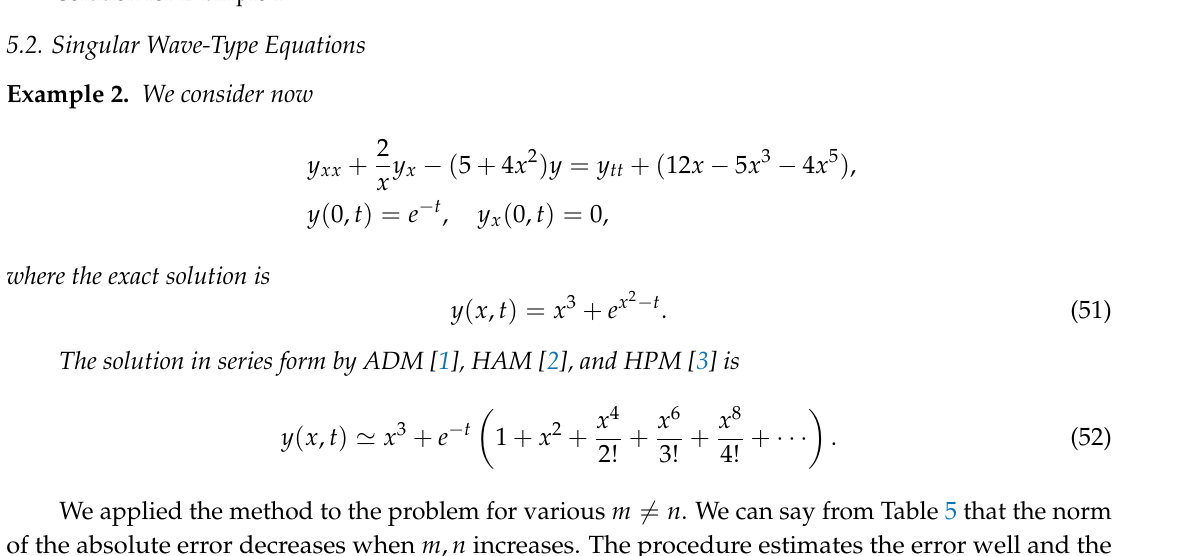
Figure 2. ( a ) absolute error, ( b ) estimated absolute error, and ( c ) corrected absolute error for 2D-BPs solution for Example